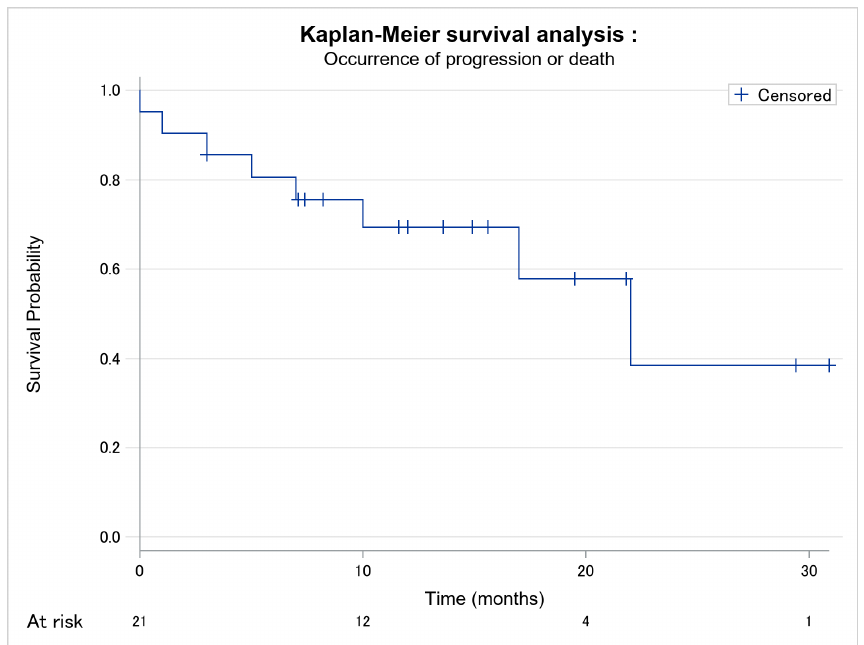
Figure 1. Kaplan–Meier survival analysis of occurrence of progression or death among the 21 patients. No missing data.